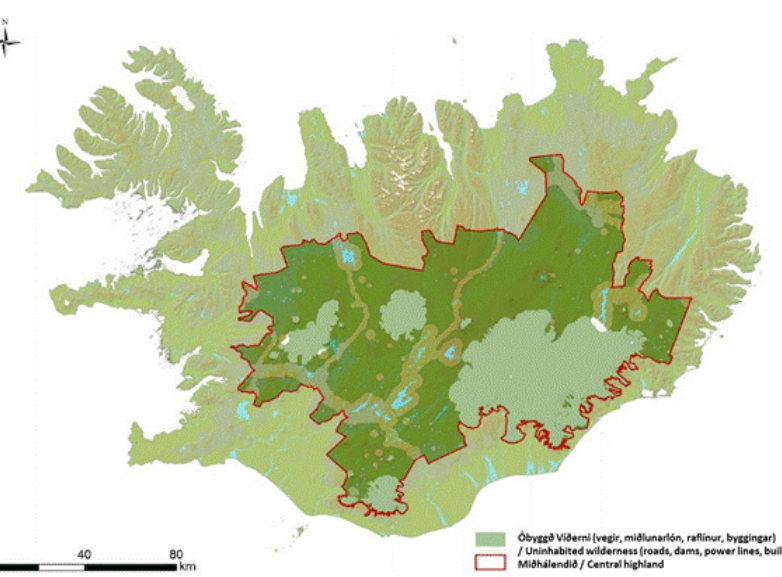
Figure 5. Wilderness mapping from Árnason, et al. [36] based on the definition of wilderness according to Act No. 60/2013 on nature protection. The dark green color represents the mapped wilderness areas within the Icelandic central highlands, and the blue green color represent ice caps.